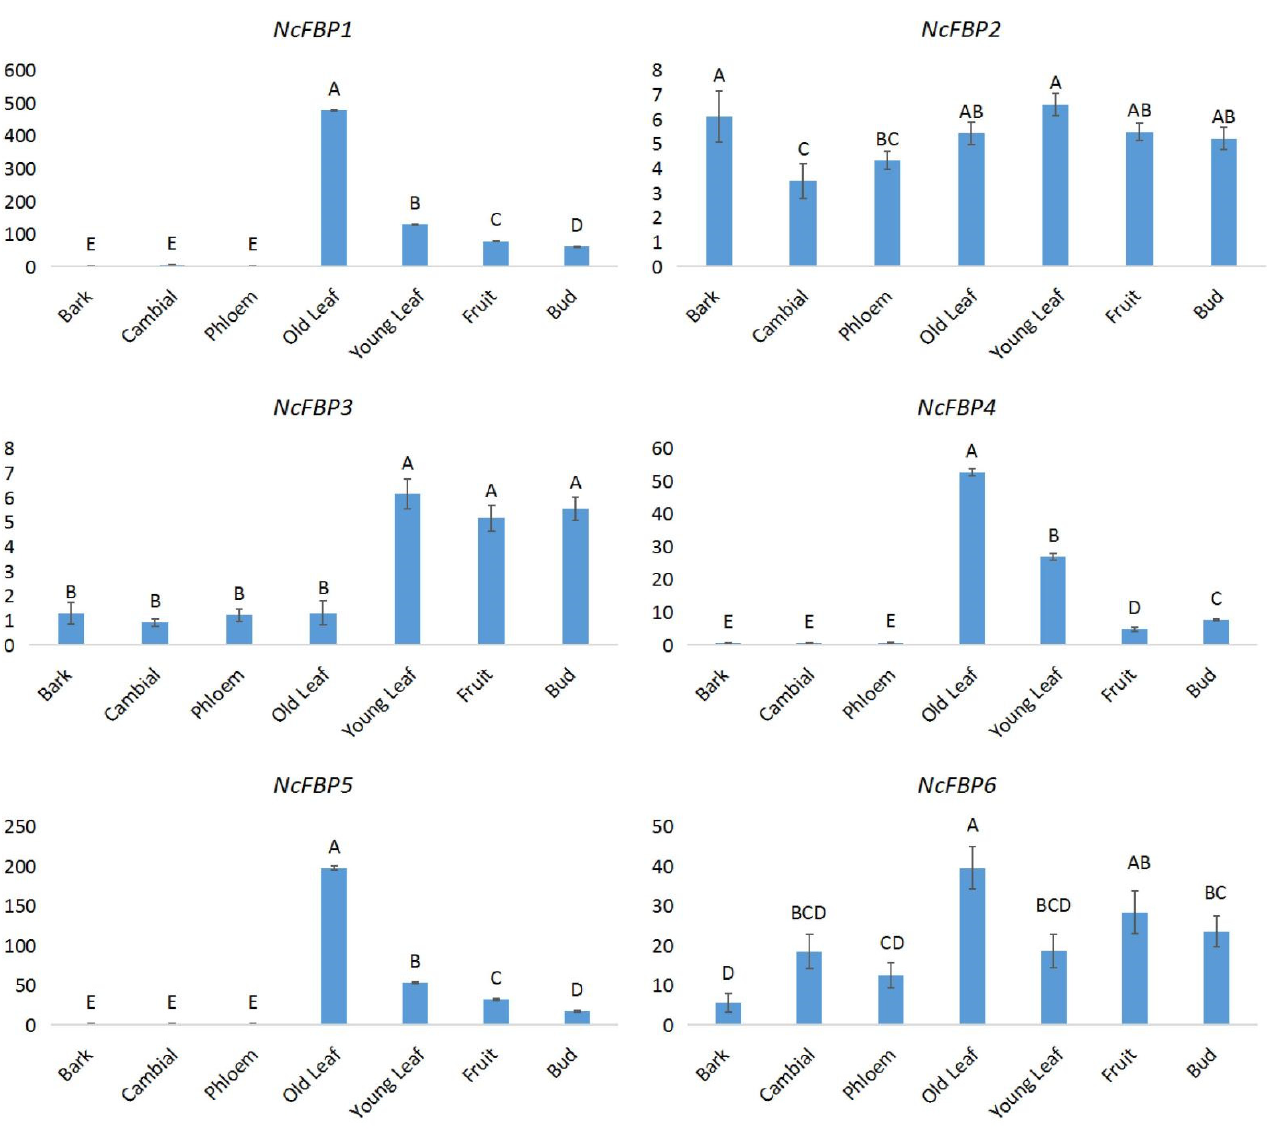
Figure 4. The expression patterns of NcFBPs genes in tissues of N. cadamba. The same capital letters indicate groups that are not significantly different from each other according to Duncan’s multiple range test, p = 0.01.